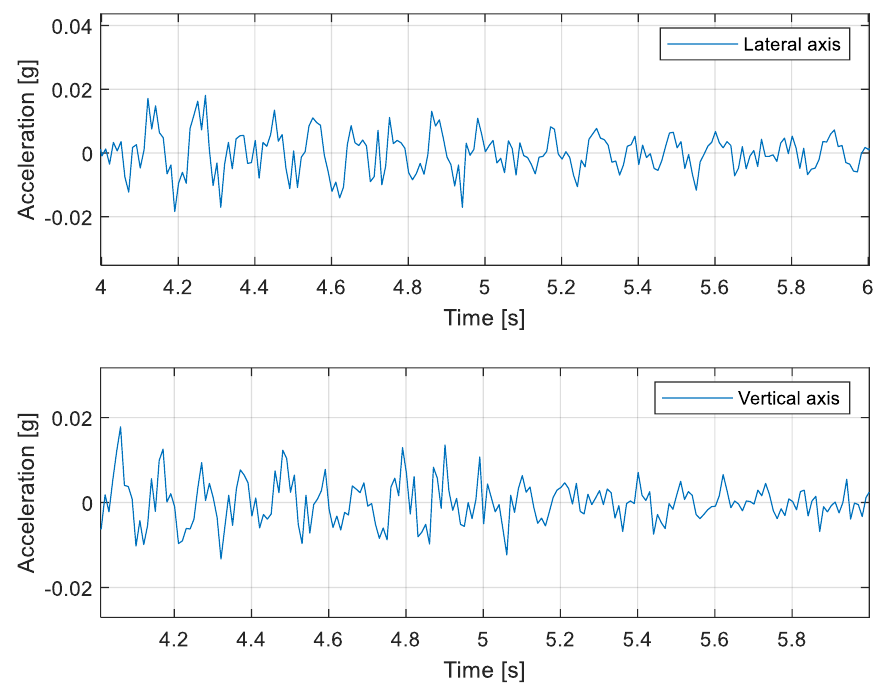
Figure 9. Exemplary acceleration time histories acquired by the wireless sensors triggered by the train passage on the lower deck. Focus on the free response of the structure after the excitation.